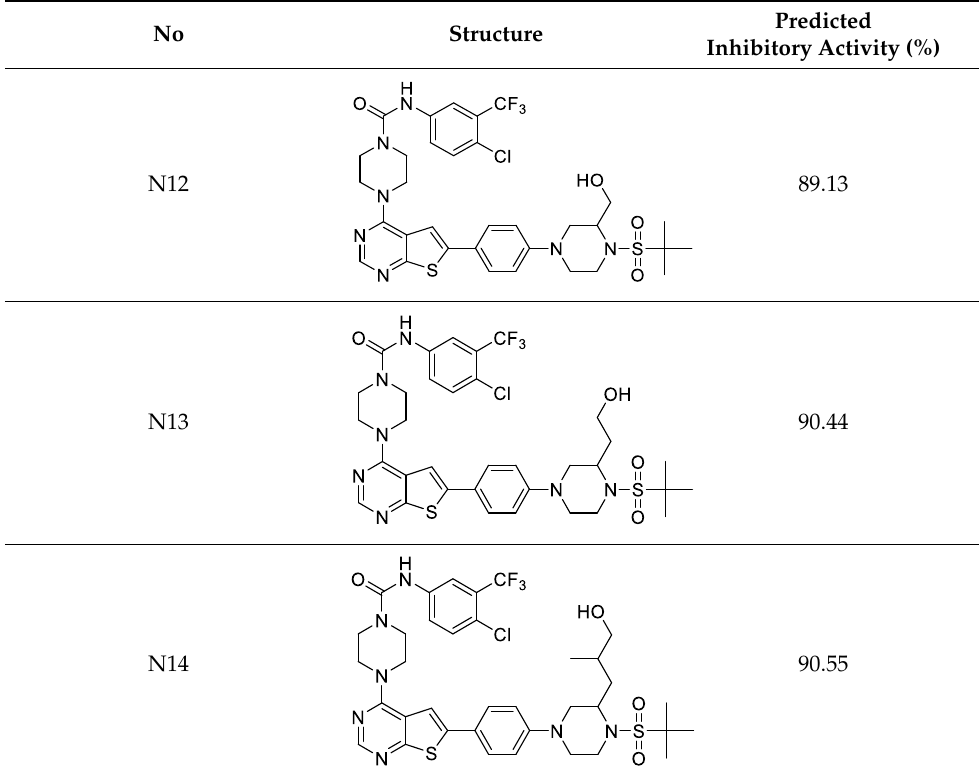
Table 5. The prediction results of ADMET parameters, pharmacokinetic properties, and drug- likeness of the most active compound 42 and the novel designed inhibitors N1-N14 .